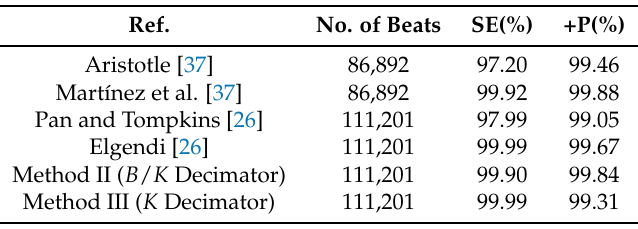
Table 6. Comparison of the QRS detection with other published algorithms on the QT database. SE stands for sensitivity, while +P stands for positive predictivity. Ref. No. of Beats SE(%) +P(%) Aristotle [37] 86,892 97.20 99.46 Martínez et al. [37] 86,892 99.92 99.88 Pan and Tompkins [26] 111,201